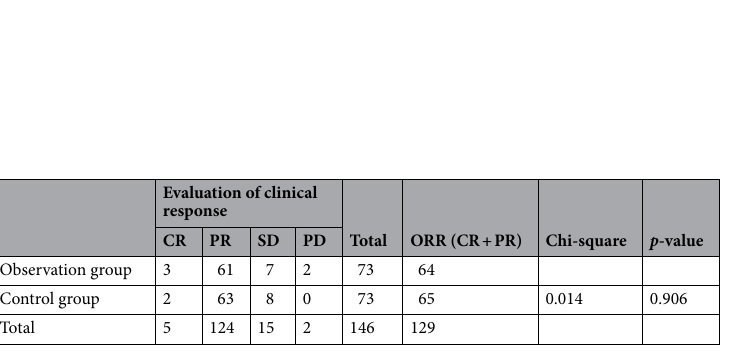
Table 2. Clinical response following the preoperative neoadjuvant chemotherapy (unit: case). CP complete response, PR partial response, SD stable disease, PD progressive disease, ORR objective response